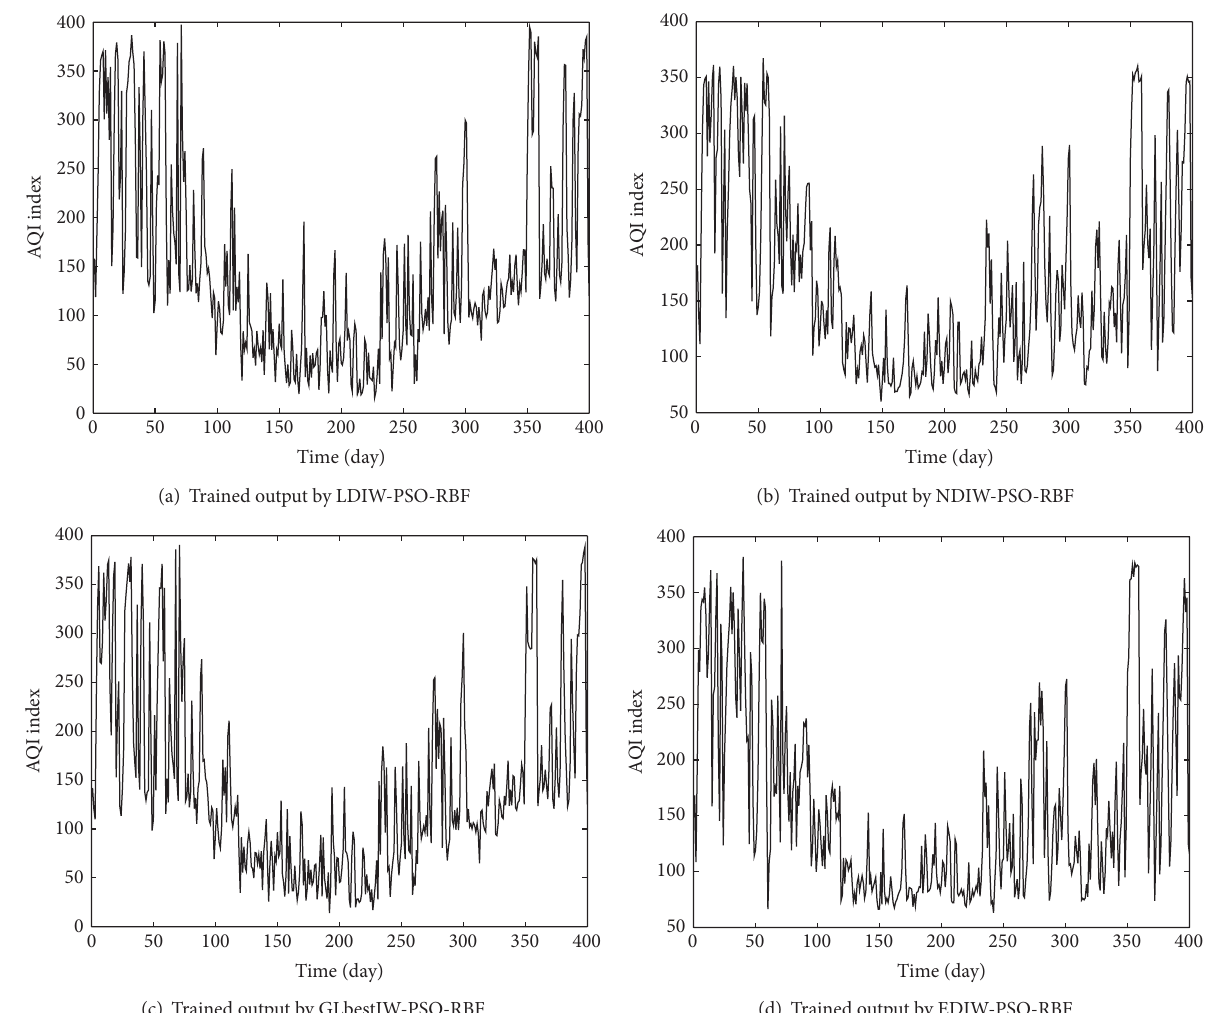
Figure 5: The trained output curve by four models for the daily air quality index (AQI) of